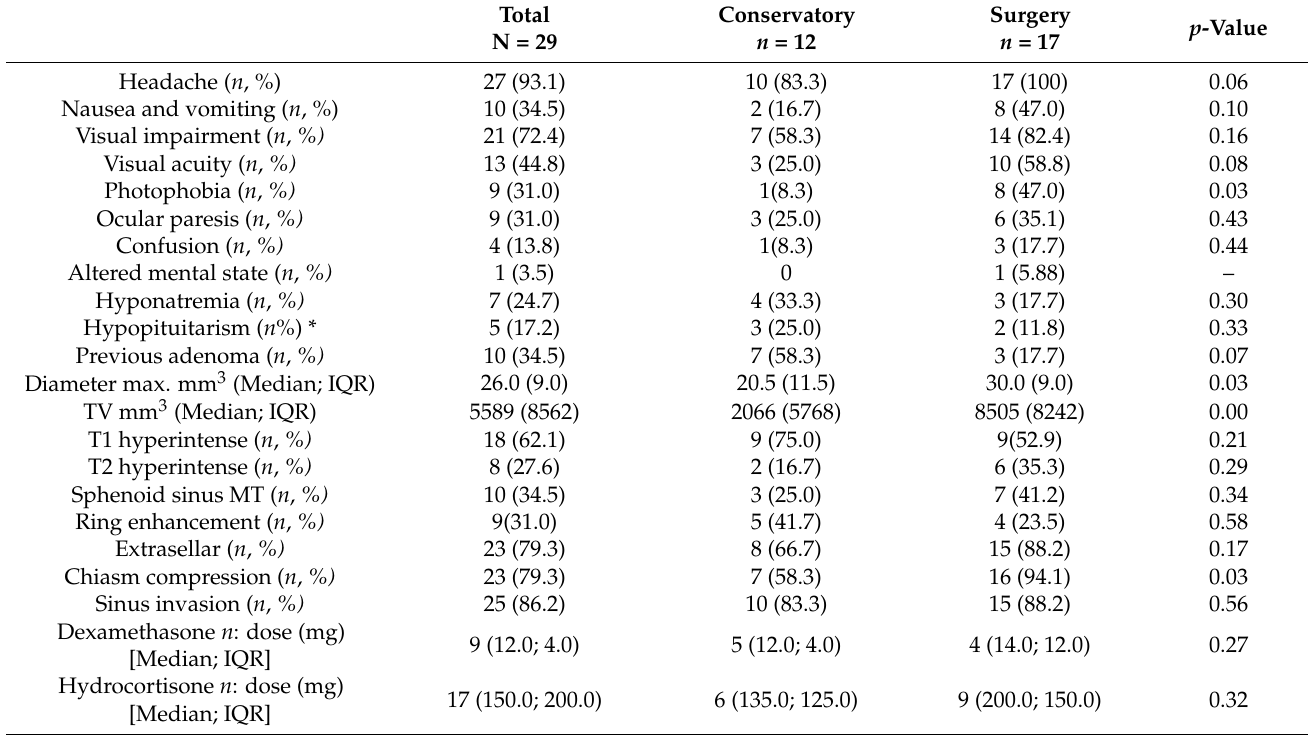
Table 3. Differences between conservatory vs. surgical approach in acute apoplexy